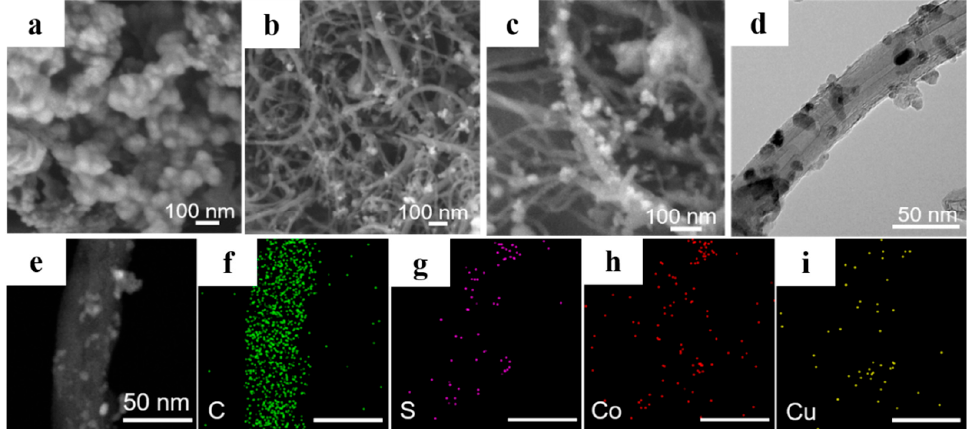
Figure 2. SEM images of ( a ) CuCo 2 S 4 , ( b , c ) CuCo 2 S 4 -1/CNT; ( d ) TEM images of CuCo 2 S 4 -1/CNT. ( e ) TEM image of CuCo 2 S 4 -1/CNT and the corresponding elemental mappings: ( f ) C, ( g ) S, ( h ) Co, ( i ) Cu.